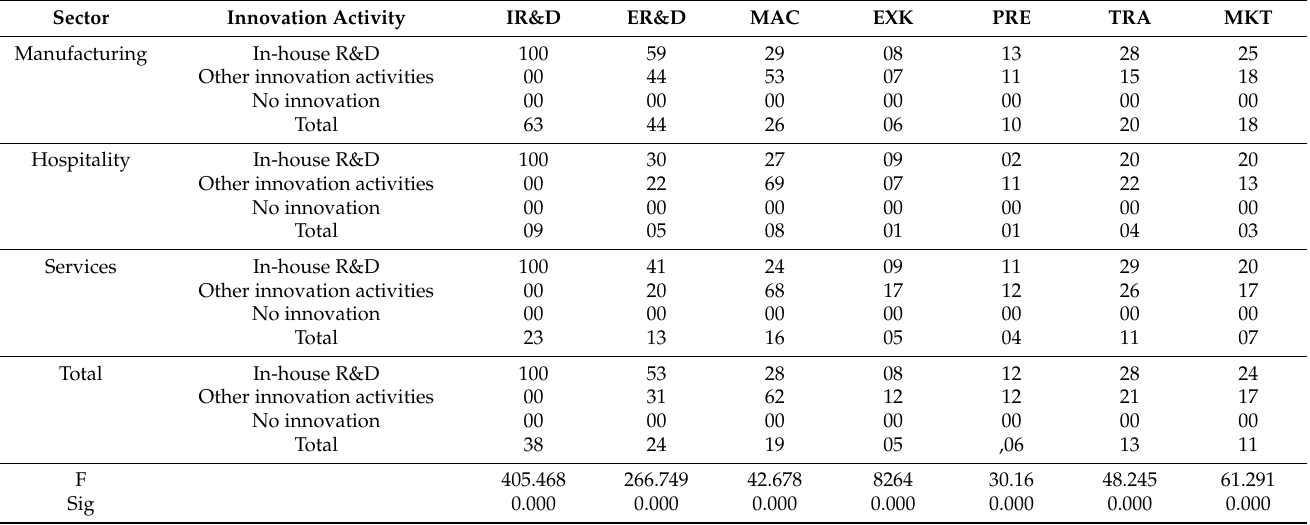
Table 7. Detailed innovation activities by industry.